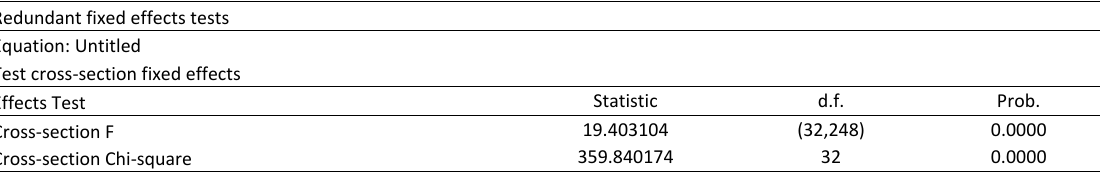
Table 1: Results of chow test